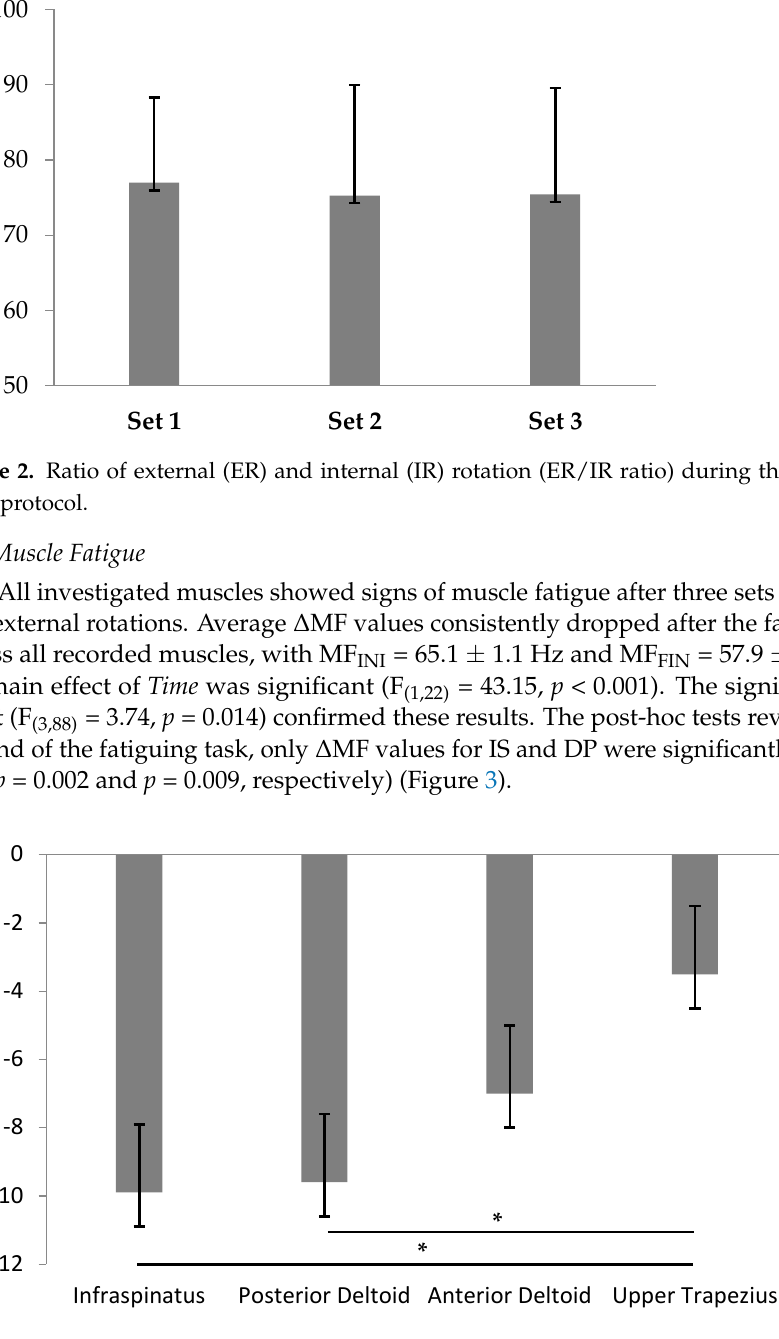
Figure 3. Difference in the median frequency ( ∆ MF) (Hz) of each muscle in all subjects after the fatigue protocol. (* Significant differences for effect of Muscle on ∆ MF in the fatiguing tasks)